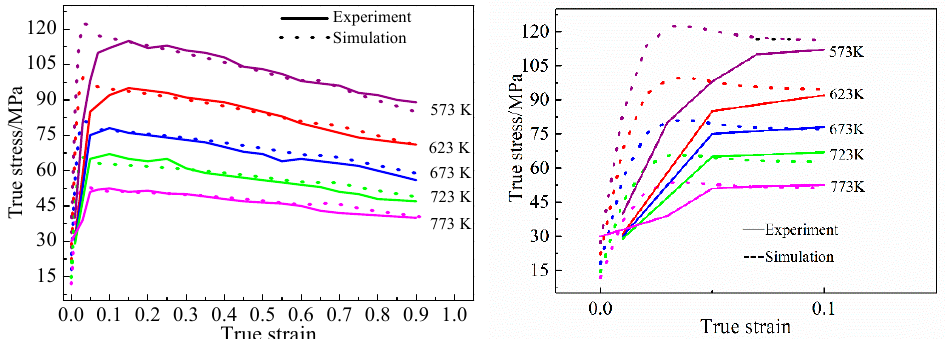
Figure 10. Comparison of simulated with experimental stress–strain curves and local amplification with strain less than